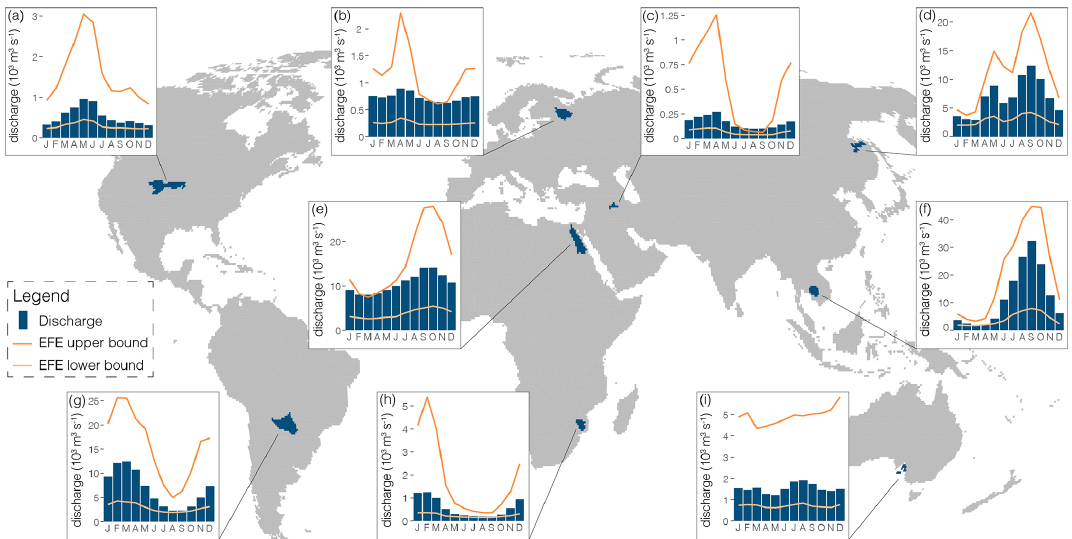
Figure A3. Case examples of environmental flow envelopes (EFEs) and mean monthly discharge in variable flow regimes. For the sake of illustration, we show both EFE lower and upper bounds as mean values of four global hydrological models (GHMs). Accordingly, the discharge presented here is the mean monthly discharge between 1976 and 2005, computed from four discharge data sets from four GHMs. Further, for each GHM, the discharge is the median of four general circulation models (GCMs) as outlined in Sect. 2.3. The anthropogenic flow alteration is clearly visible in some of these sub-basins: for example, the spring peak flow in Fig. A3b has decreased whereas summer flows have substantially increased compared with pre-industrial EFEs.